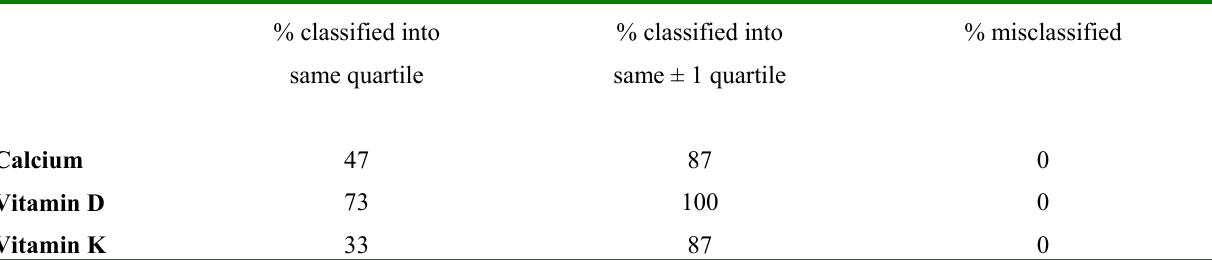
Table 3. Cross-classification analysis to determine proportion of participants classified into the same, or same ± 1 quartile based on FFQ and 5DDR intakes. % misclassified % classified into % classified into same quartile same ± 1 quartile Calcium 47 87 0 Vitamin D 73 100 0 Vitamin K 33 87 0 For calcium: quartiles 1 to 4 for FFQ were <1,185, 1,185–1,764, 1,765–2,262, >2,262 mg/d; Quartiles 1 to